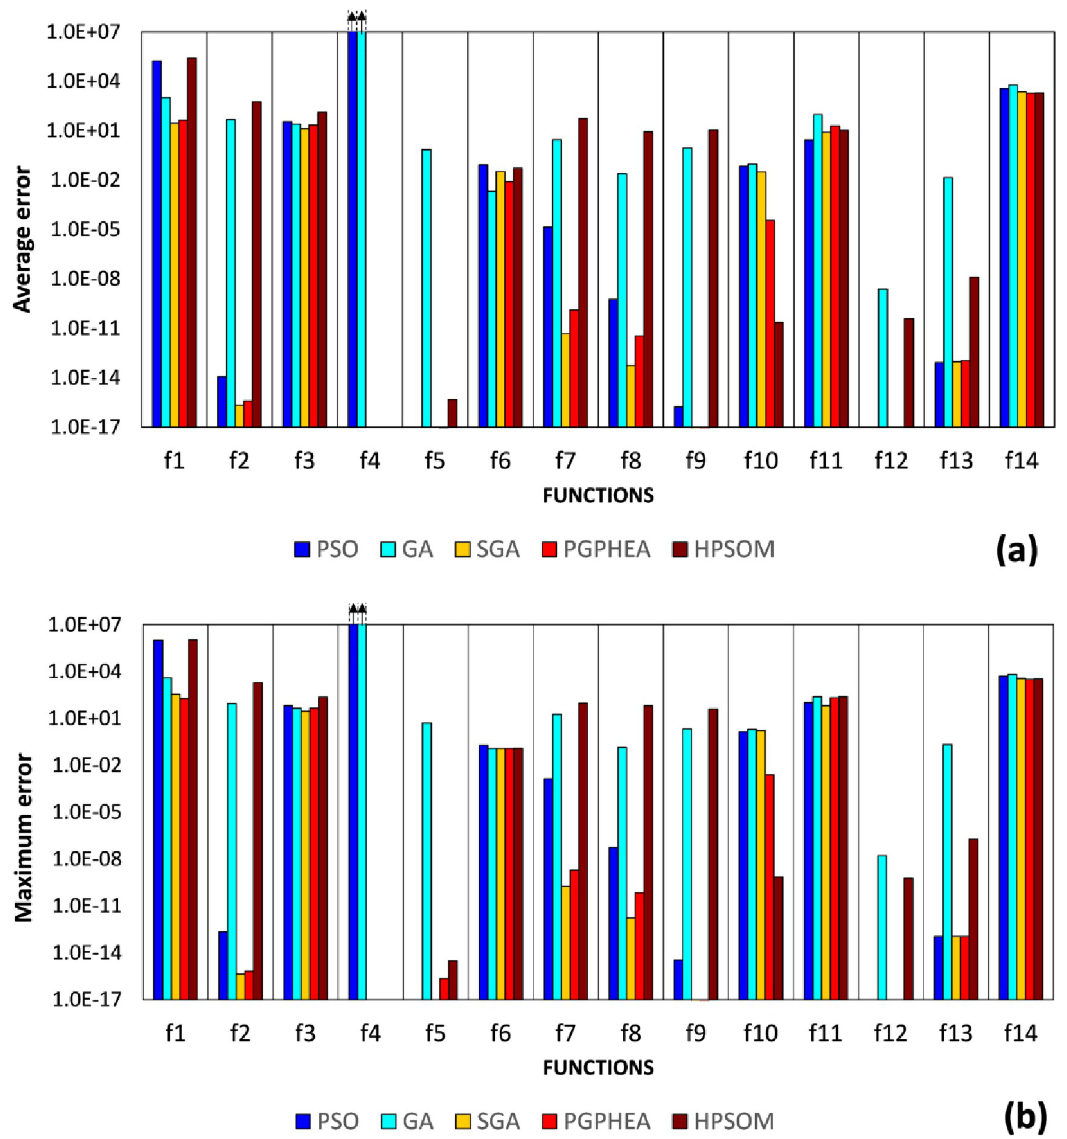
Fig 8. Comparison of algorithmic performance in solving the continuous problems of Set A: a) average error, b) maximum error in predicting the global optimum.